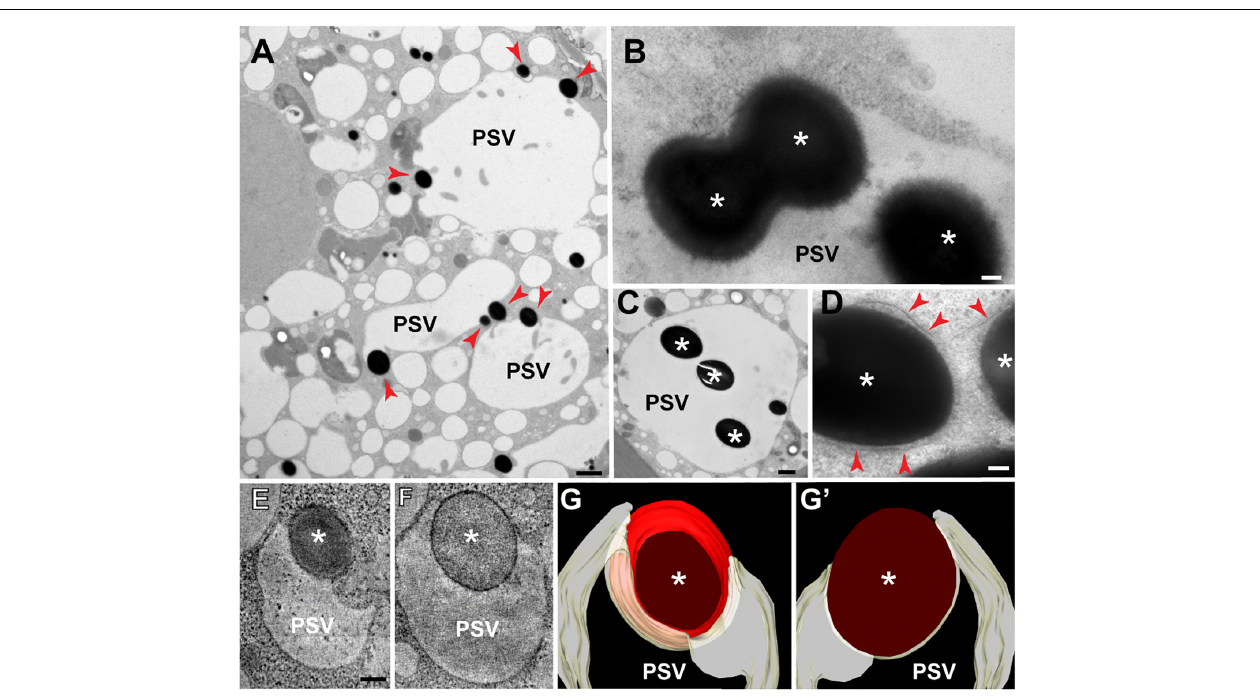
FIGURE 2 | Transmission electron microscopy of storage protein sequestration by microautophagy in maize aleurone cells. (A–D) Aleurone cells at 15 DAP with developing protein storage vacuoles (PSVs). (A) Storage protein inclusions (asterisks) indicated by red arrowheads at the periphery of PSVs. (B) Two inclusions (asterisks) merging inside a vacuole. (C) Vacuole with multiple inclusions. (D) Storage protein bodies (asterisks) surrounded by ER membrane (arrowheads) still in the cytoplasm. (E–G (cid:48) ) Electron tomographic analysis of a vacuole engulfing a storage protein body (asterisk) at 20 DAP. (E,F) Two tomographic slices at different depths of the same vacuole. (G,G (cid:48) ) Two views of the tomographic reconstruction of the PSV and inclusion from the same tomogram. Scale bars = 1 µ m in (A,C) ; 100 nm in (B,D–G (cid:48) )